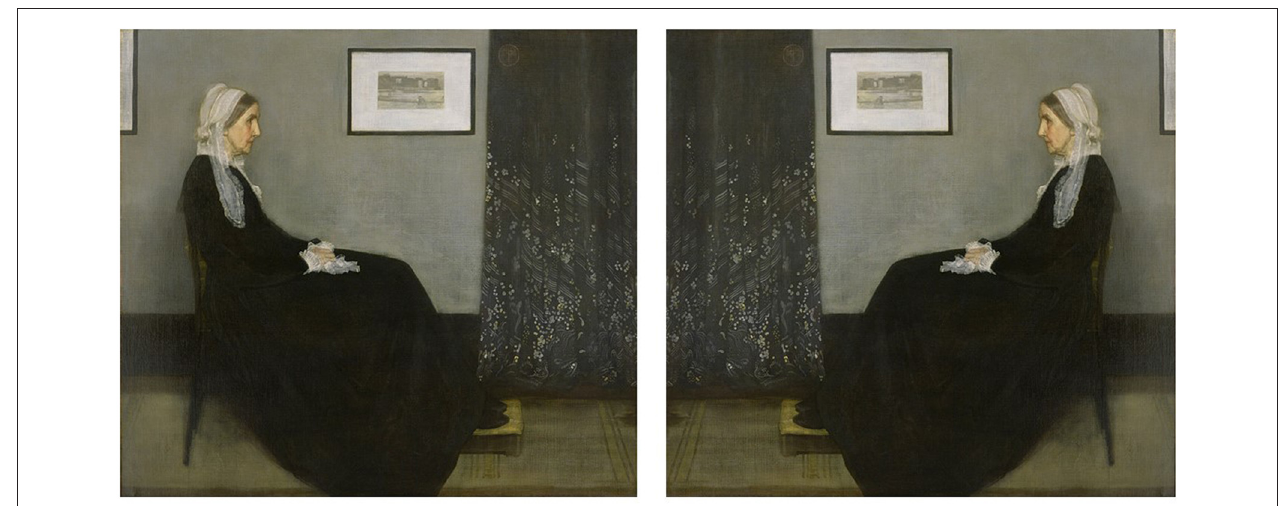
FIGURE 2 | Whistler’s Arrangement in Black and Grey No. 1 . Which version is correct? (James Abbott McNeill Whistler, Whistlers Mother high res, marked as public domain, more details on Wikimedia Commons).